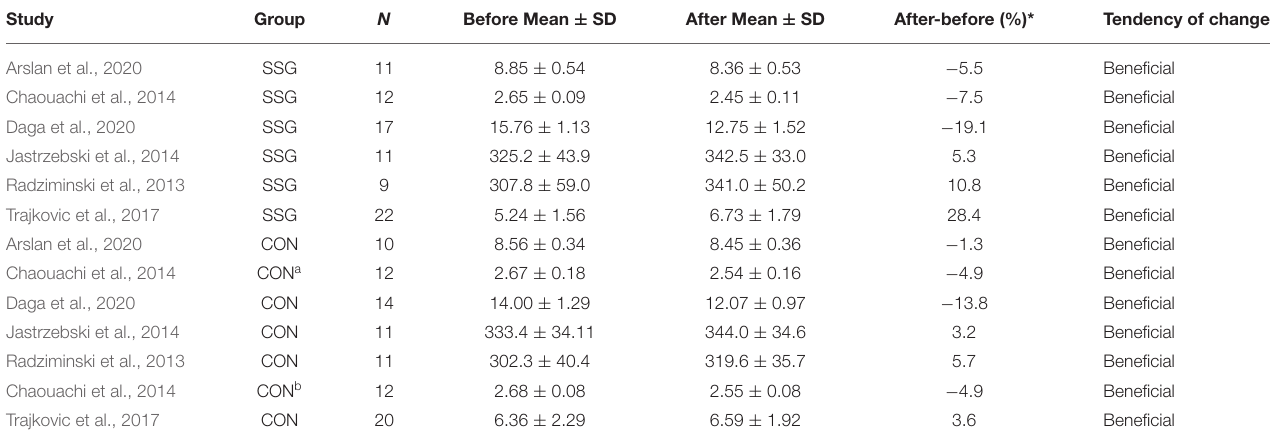
TABLE 7 | Summary of the included studies and results of technical execution before and after intervention.